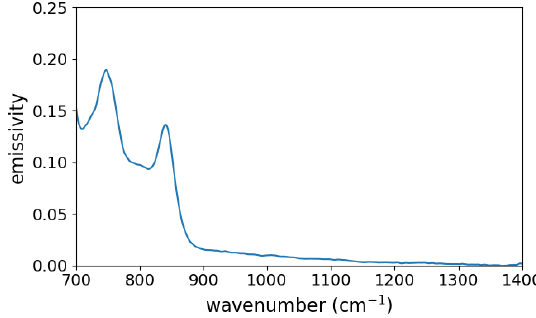
Figure 6. The spectral emissivity of the outer